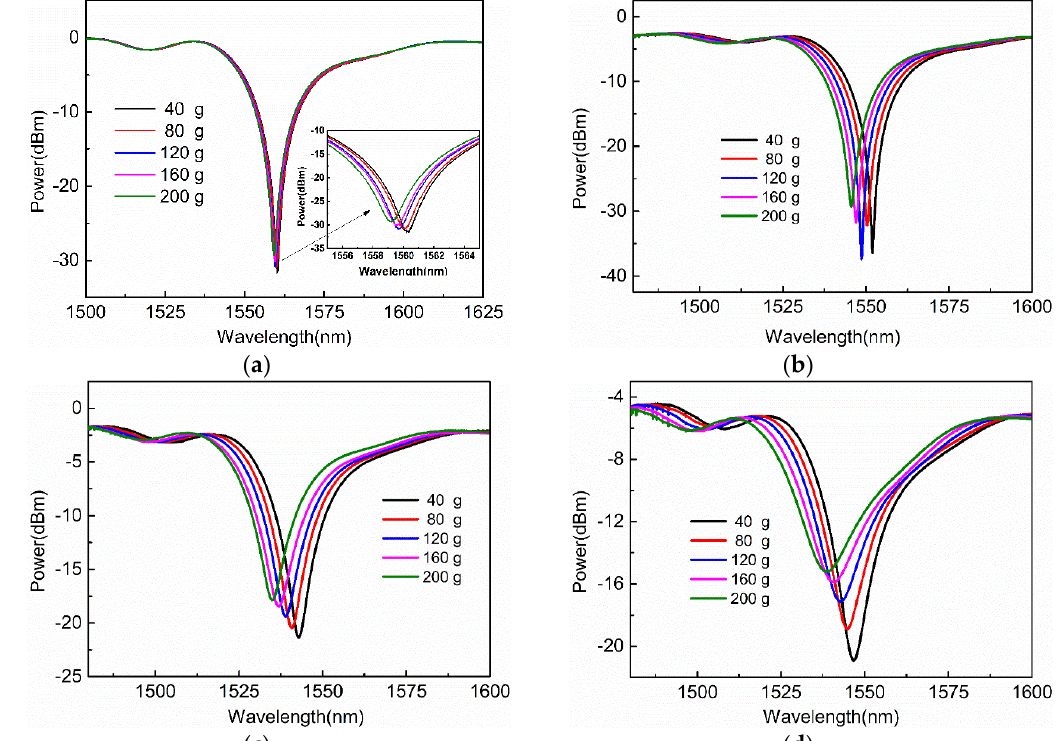
Figure 10. Transmission spectra of LPFG in different NaCl solutions, ( a ) uncoated LPFG, ( b ) LPFG coated with (In 2 O 3 ):(Ga 2 O 3 ):(ZnO) 6:1:3, ( c ) LPFG coated with (In 2 O 3 ):(Ga 2 O 3 ):(ZnO) 7:1:2, ( d ) LPFG coated with In 2 O 3 ):(Ga 2 O 3 ):(ZnO) 7.5:1:1.5. Coatings 2020 , 10 , x FOR PEER REVIEW